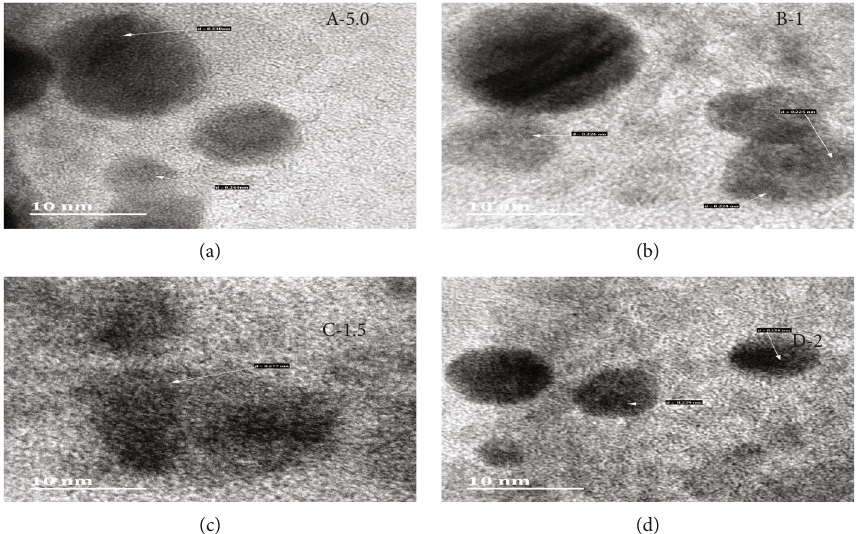
Figure 4: HR-TEM images of (a) HAART-AgNPs (0.5 M), (b) HAART-AgNPs (1 M), (c) HAART-AgNPs (1.5M), and (d) HAART-AgNPs (2 M) with interplanar spacing (d).